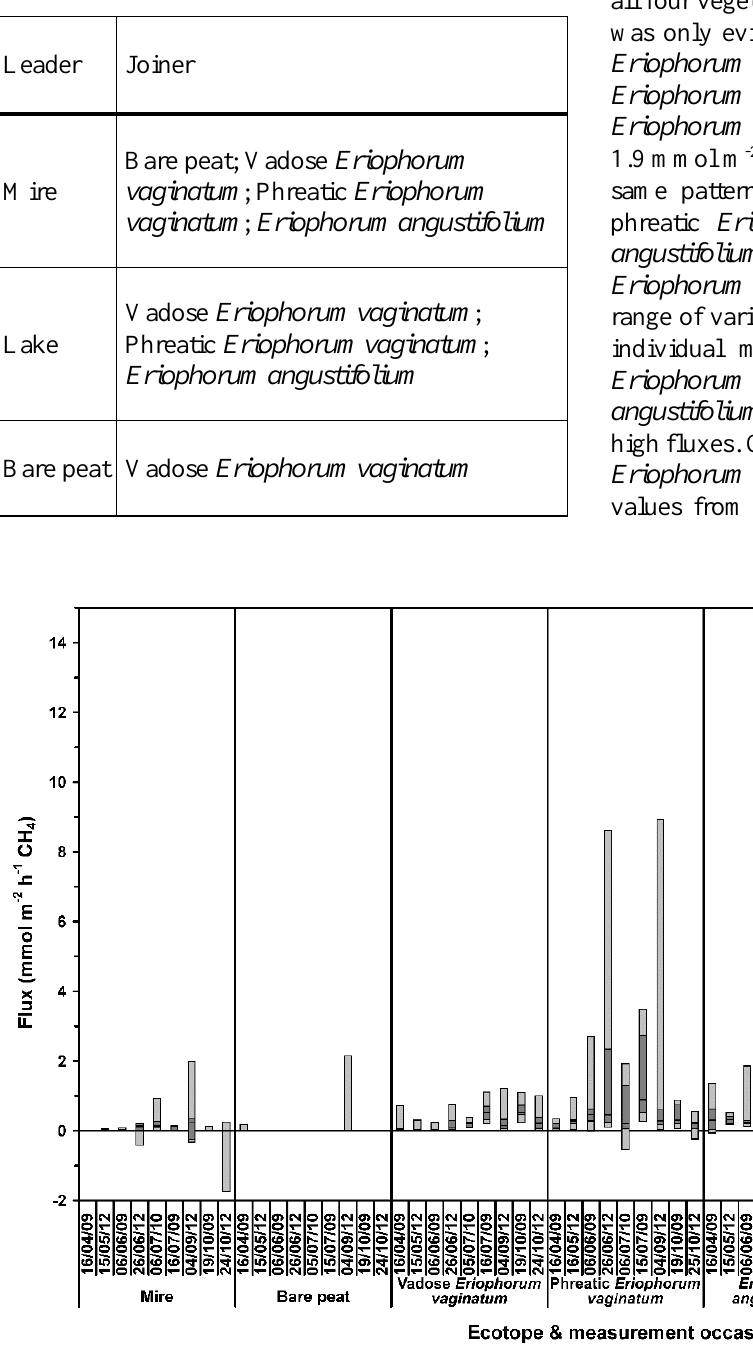
Figure 4. CH 4 fluxes (mmol m -2 h -1 ) within the ecotopes, shown in quartiles (bars) and listed in order of seasons. Positive values show a flux from the peatland to the atmosphere and negative values are a flux from the atmosphere to the